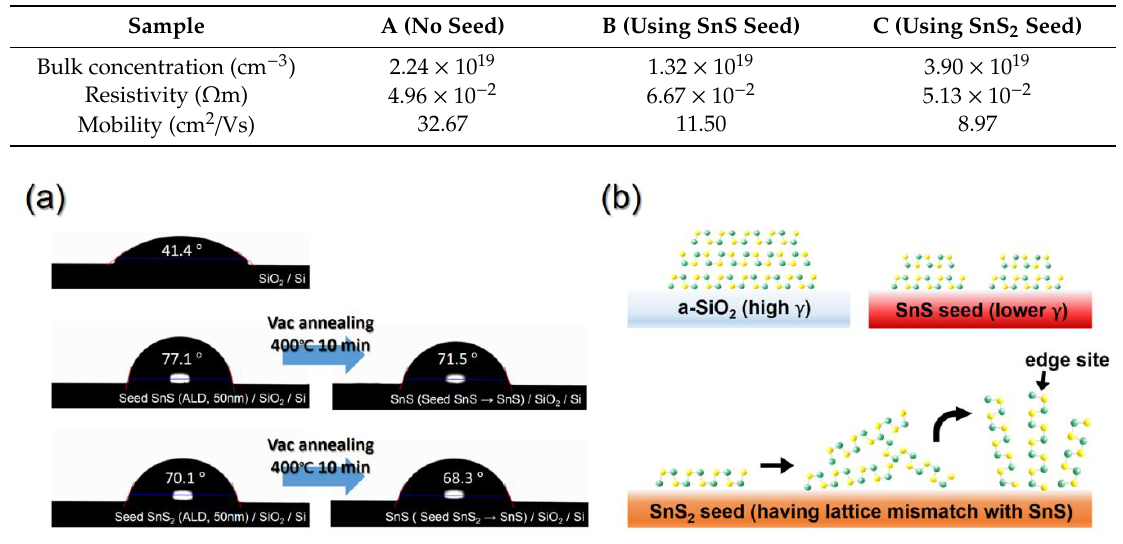
Figure 6. ( a ) Water contact angle analysis of SiO 2 substrate and seed layers. ( b ) Grain growth behavior of SnS films at the interface with SiO 2 substrate and seed layers.